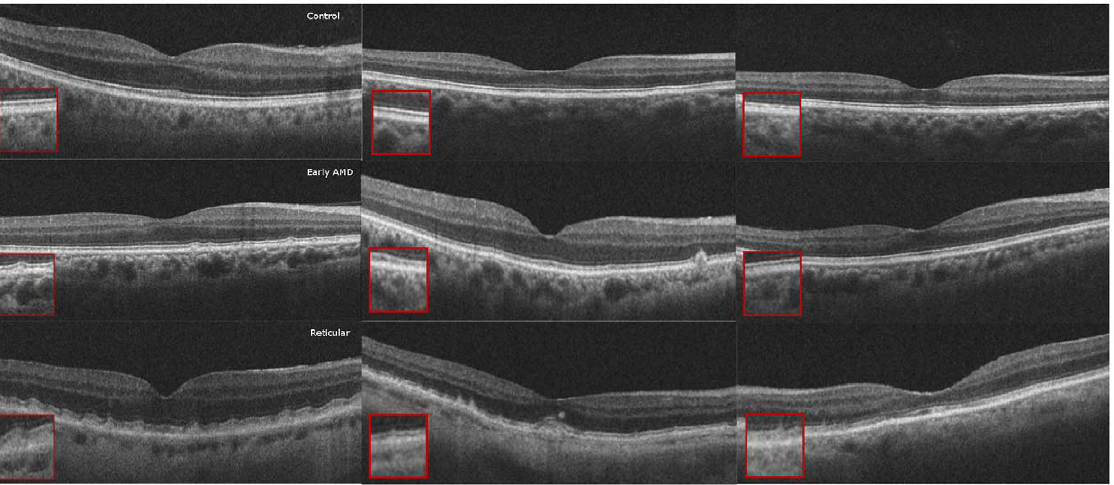
Figure 8. Qualitative High Density (HD) Raster Scan Assessment of Choriocapillaris. HD-raster scans of the control group (top) had a distinct granular-appearing choriocapillaris layer, in contrast to only 45% of the early age-related macular degeneration group (center) and none of the reticular group (bottom), in whom this layer was lacking.